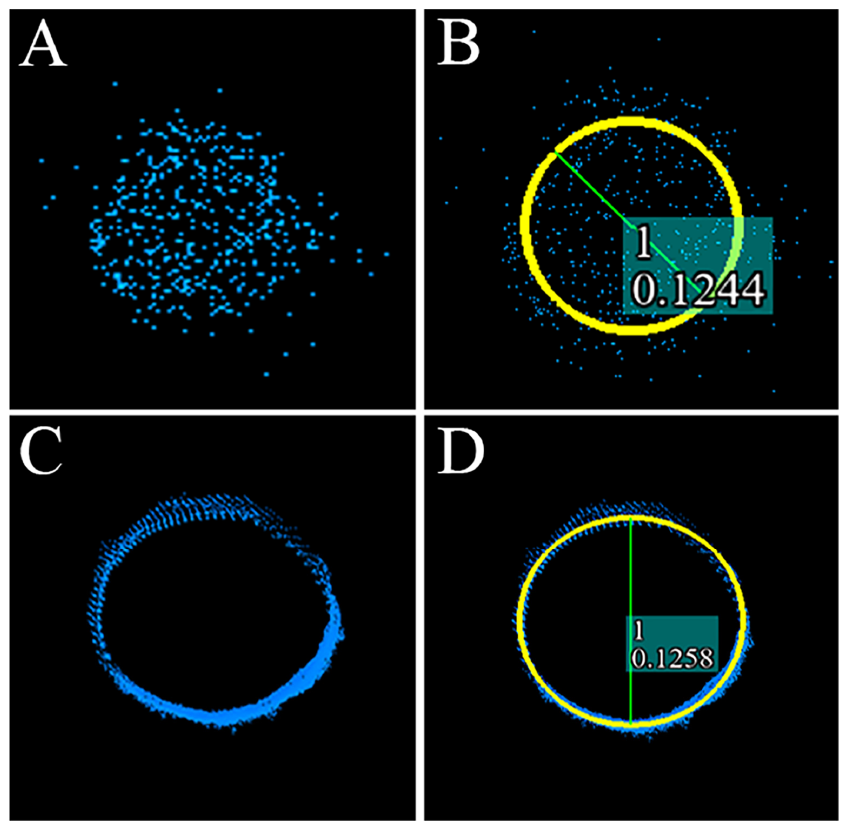
Figure 4. LiDAR point cloud data fitted to DBH. ( A , B ) Results of the backpack LiDAR point cloud